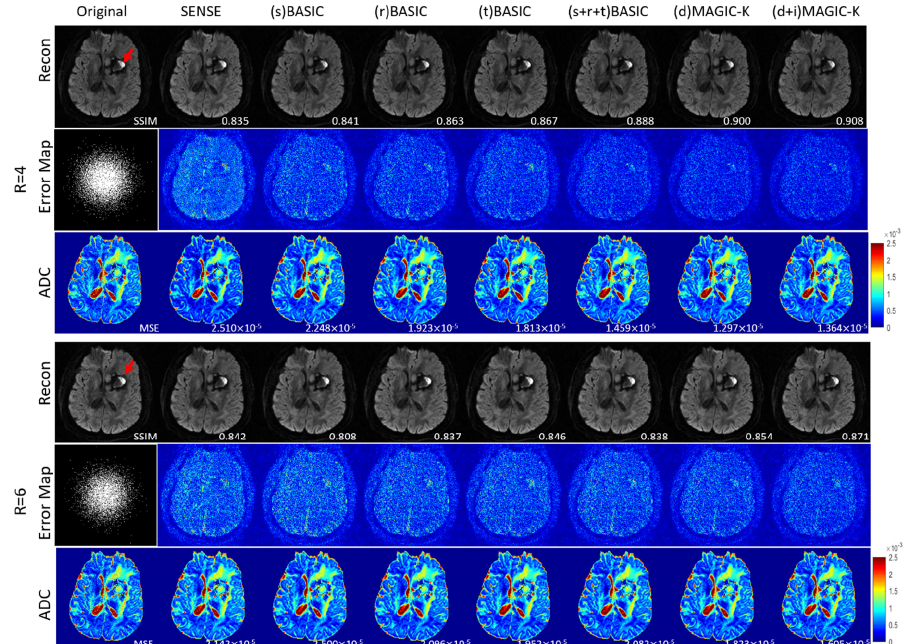
Figure 7. Comparison of the reconstructed images by different image augmentation strategies, using variable density undersampling in a tumor patient with lymphatic metastasis. The SSIM is listed at the bottom-right of each reconstructed image. The error map was ×10 amplified for better visualization. The MSE is listed at the bottom-right of each ADC map. The tumor is depicted by a red arrow.